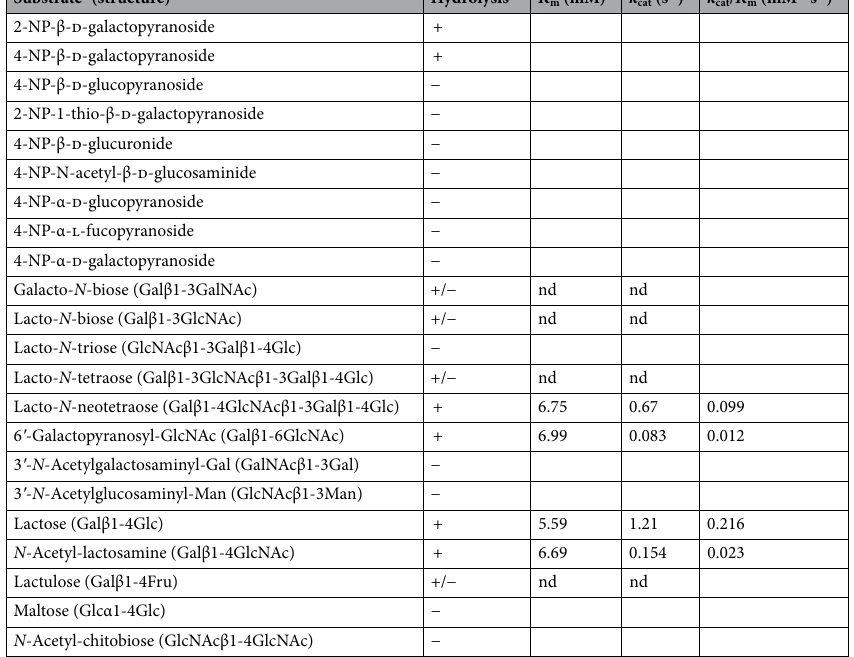
Table 4. Activity of enzyme Bdg2A. nd not determined. a Carbohydrates used as substrates. NP nitrophenyl, Glc glucose, Gal Galactose, GlcNAc N -acetylglucosamine, GalNAc N -acetylgalactosamine, Man mannose, Fru fructose. b +, substrate is totally hydrolyzed after 16 h reaction in the conditions described in “Methods”; +/−, substrate is partially hydrolyzed after 16 h reaction in the conditions described in “Methods”; − , no activity detected.